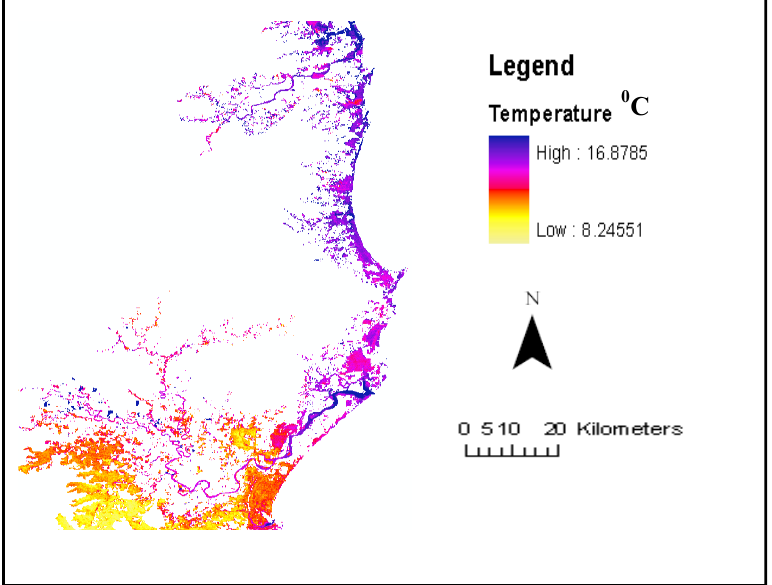
Figure 5. Estimated Land surface temperature